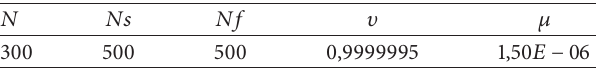
Table 1: FXLMS optimal parameters for active-adaptive vibration control.